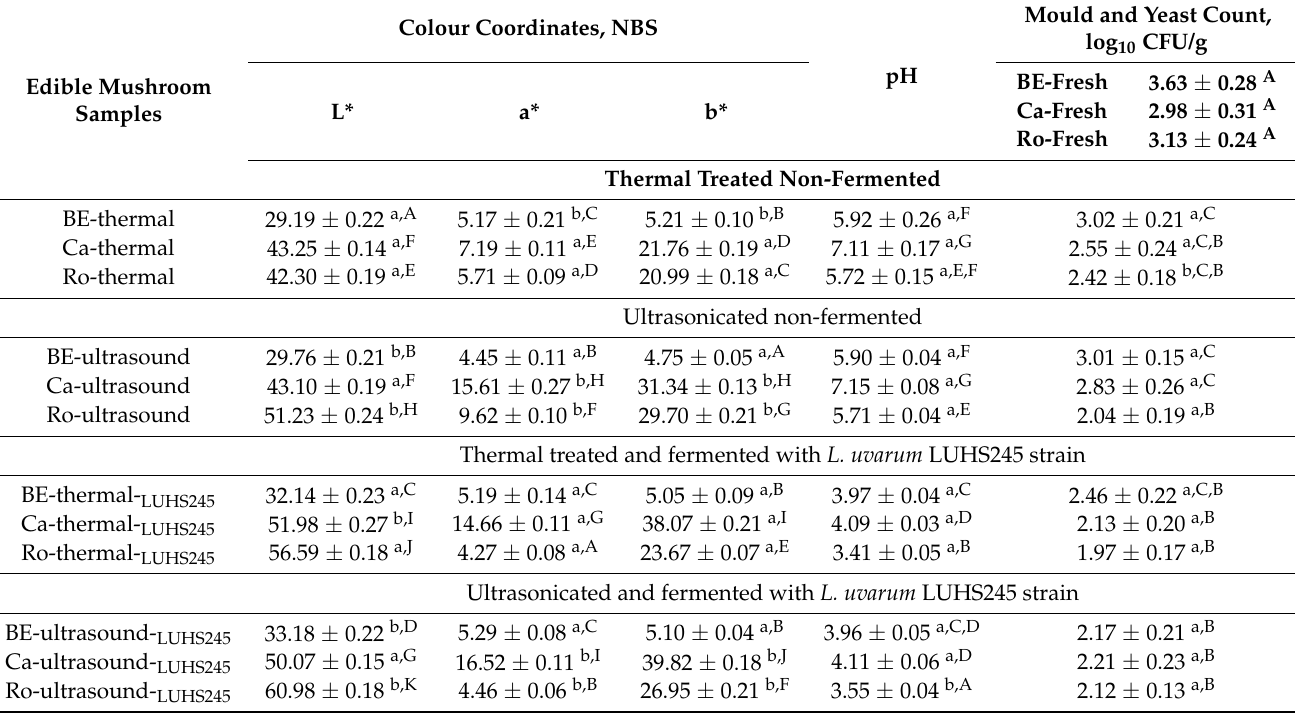
Table 1. Colour coordinates (L* lightness; a* redness or -a* greenness; b* yellowness or -b* blueness); and pH of the edible